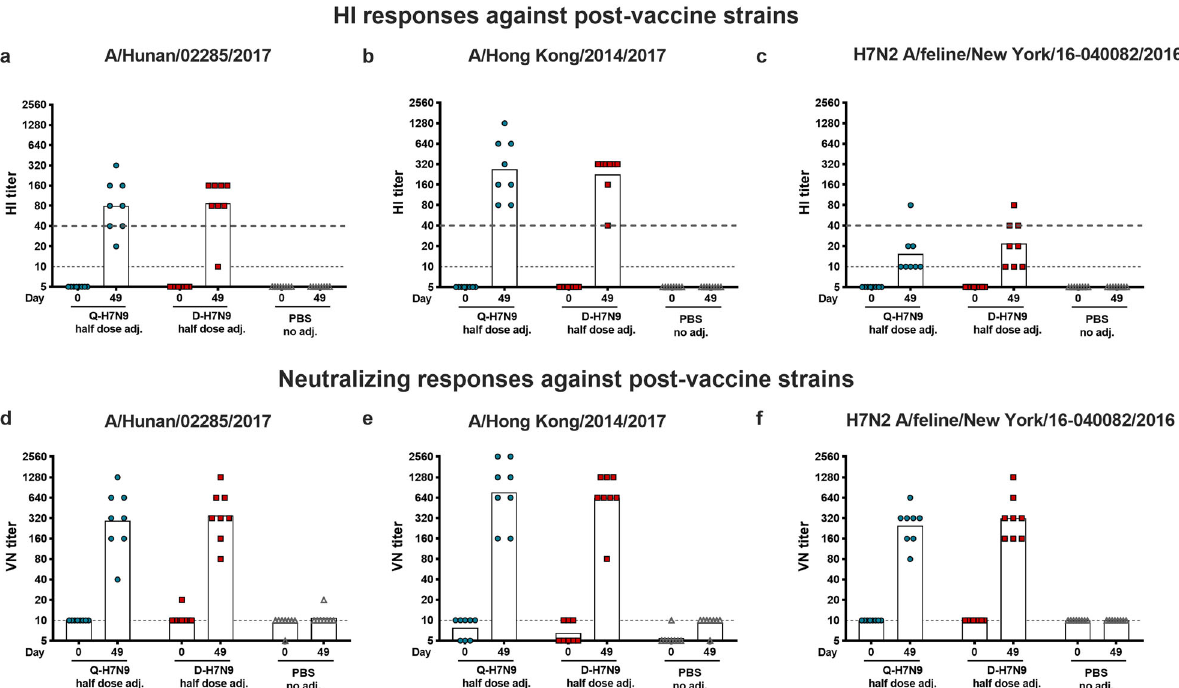
Fig. 4 Hemagglutination inhibition (HI) and microneutralization titers (VN) against fi fth wave H7N9 viruses and a North American lineage H7N2 virus. The HI titers against H7N1 A/Hunan/02285/2017 ( a ), H7N1 A/Hong Kong/2014/2017 ( b ), and H7N2 A/feline/New York/16- 040082/2016 ( c ) are plotted on the y -axis. The dashed gray line represents an HI titer of 1:40. The x -axis shows the timepoints (day 0, 49) and the treatment groups are indicated. VN responses against the same viruses are shown in d – f . The y -axis shows the VN titer, the timepoints (day 0, 49) and treatment groups are indicated. The dashed gray line at an HI or VN titer of 1:10 indicates the limit of